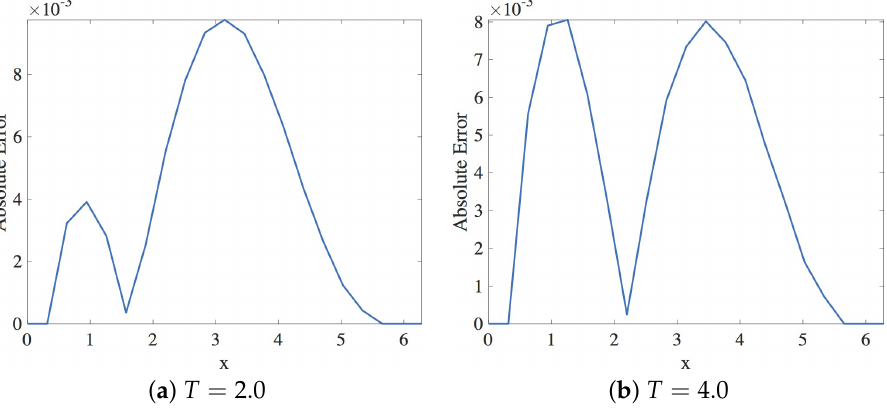
Figure 29. Plot of the absolute error vs. x using Scheme 3 for Numerical Experiment 2. The spatial and temporal step sizes are h = π /10 and k = 0.001, respectively. Table 6. L 1 and L ∞ errors for various k when h = π /10 when Scheme 3 is employed to approximate Numerical Experiment 2 at T = 2 and T =